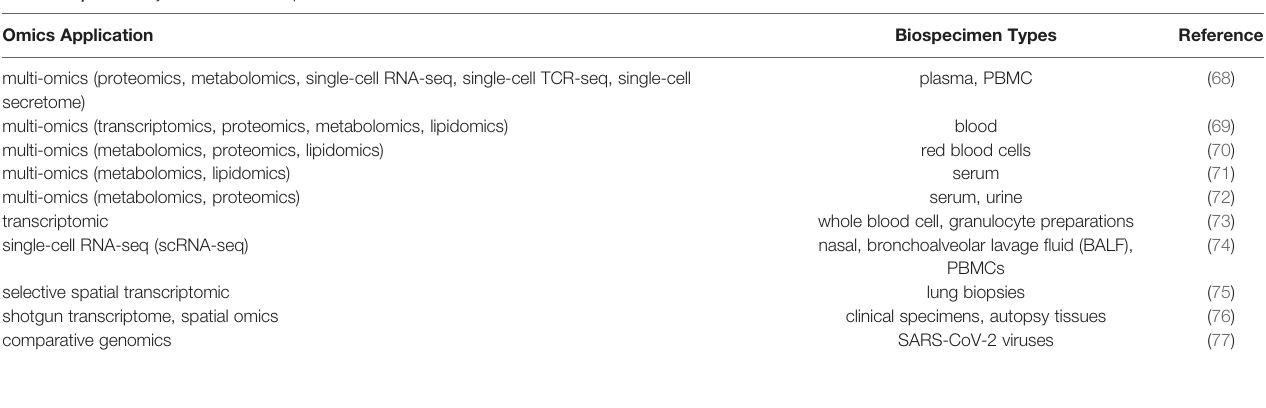
TABLE 1 | Summary of the main multiple omics data about COVID-19. Omics